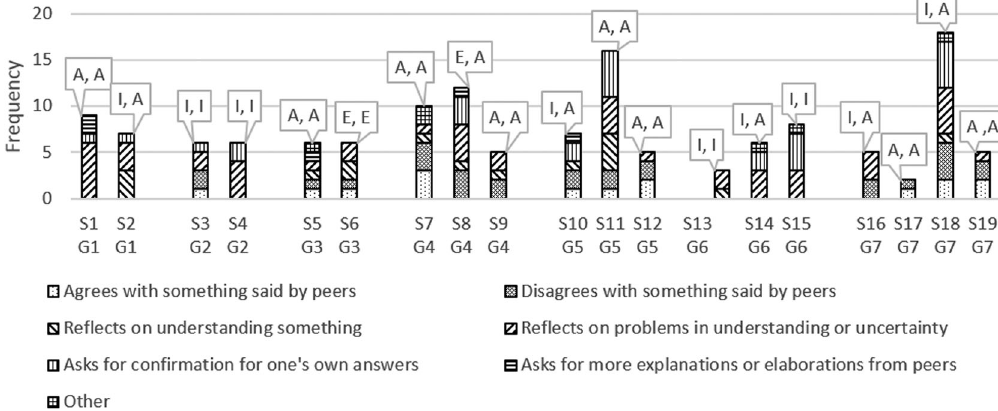
FIG. 6. A substructure of the category “ metalevel discussions. ”